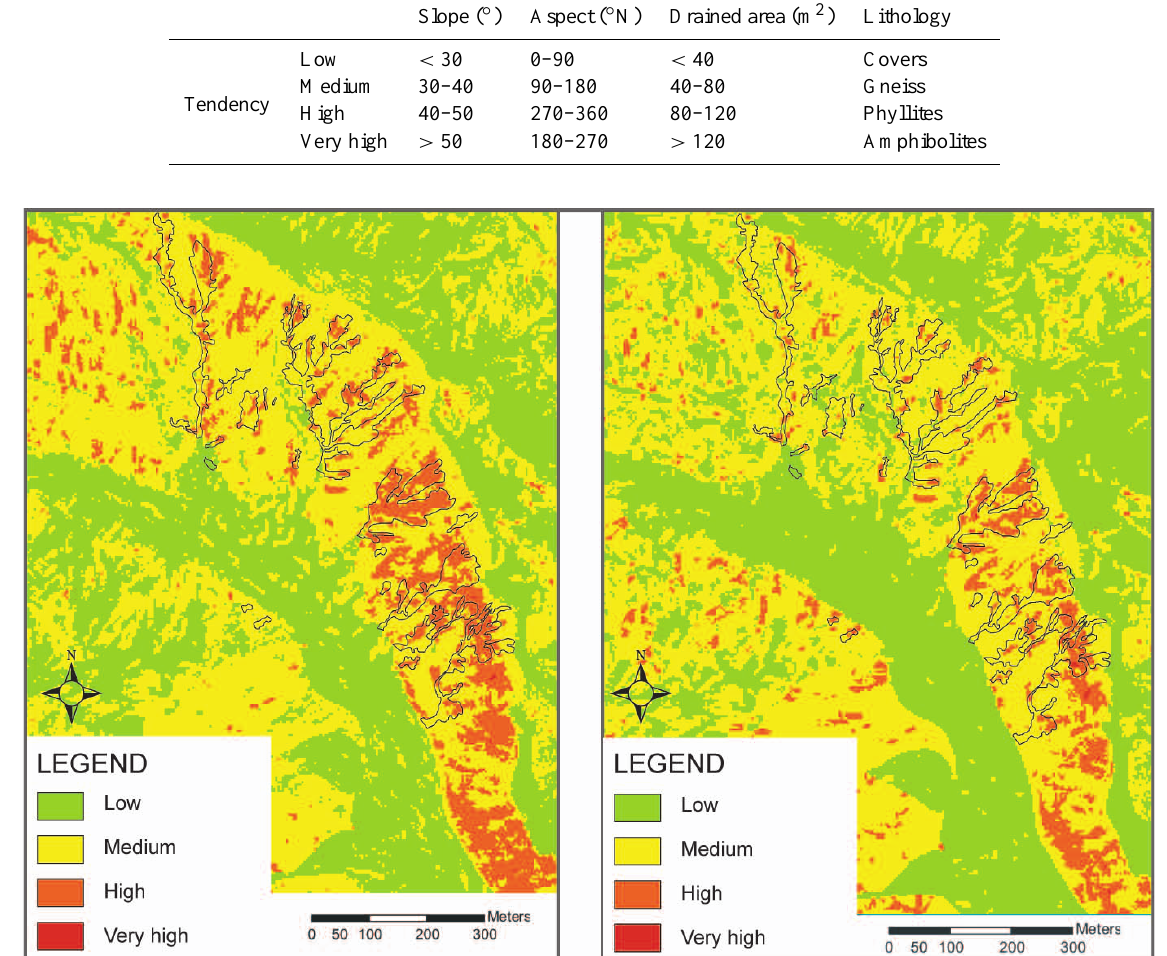
Fig. 11. Maps of landslide prone areas obtained using all the parameters (a) and omitting the aspect (b) .